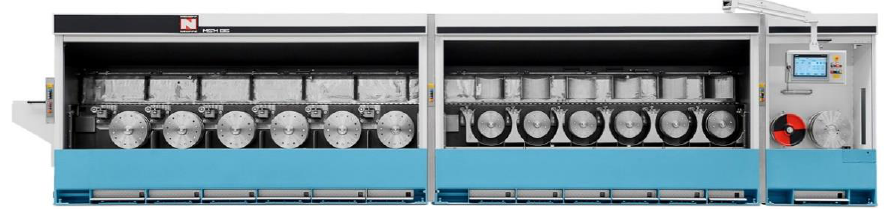
Figure 1. The Nieho ff MSM-86 multi-stage wiredrawing industrial machine (Nieho ff Stranding Technology, Badalona, Spain) with a maximum of 12 stages used to produce the final